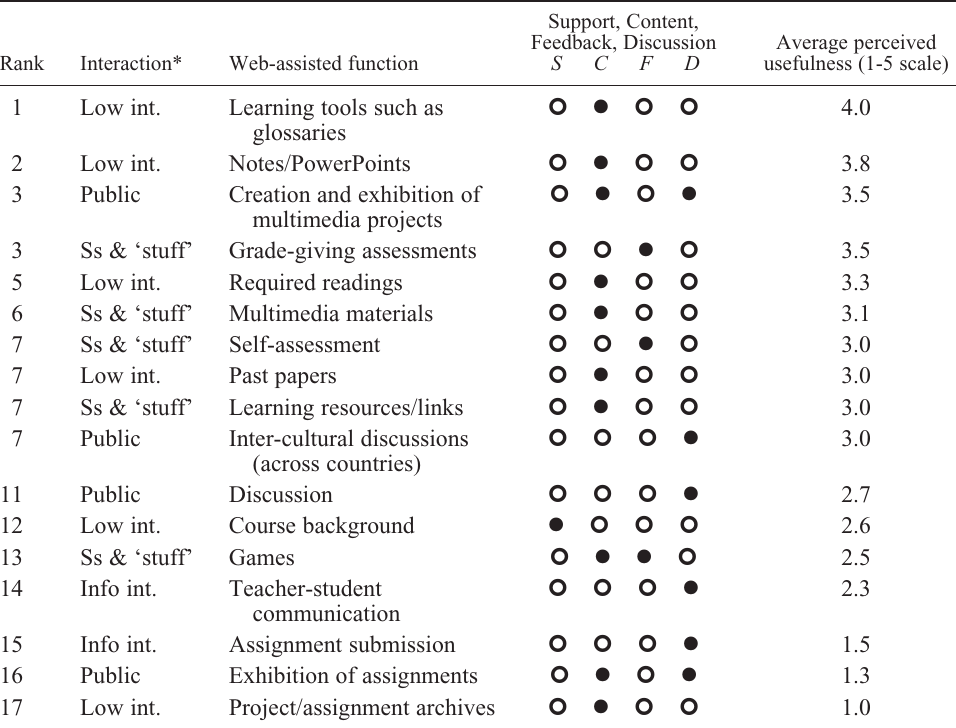
Support, Content, Feedback,